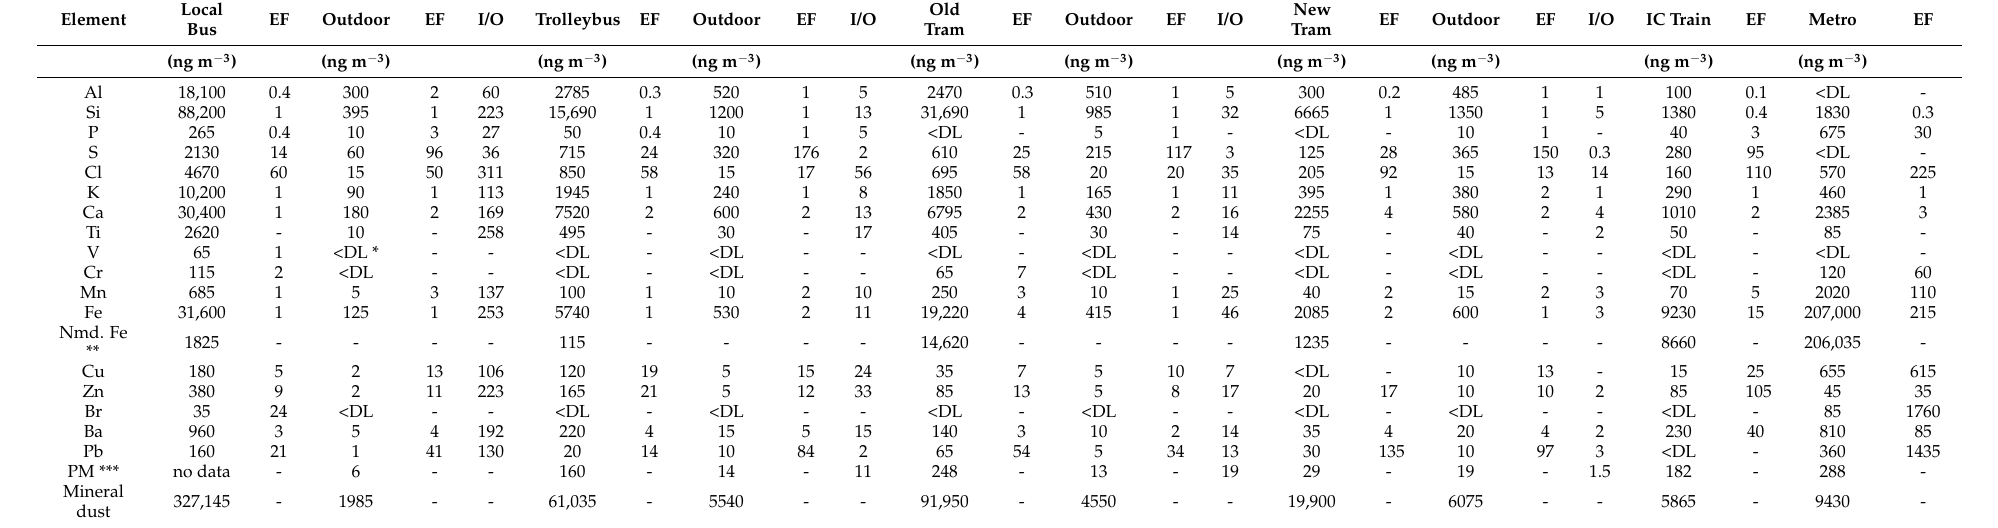
Table 5. Elemental concentration, mineral dust concentration and enrichment factor (EF) in PM coarse fraction in different vehicles in 2014; outdoor concentration (ATOMKI monitoring site) with EF and indoor/outdoor (I/O)